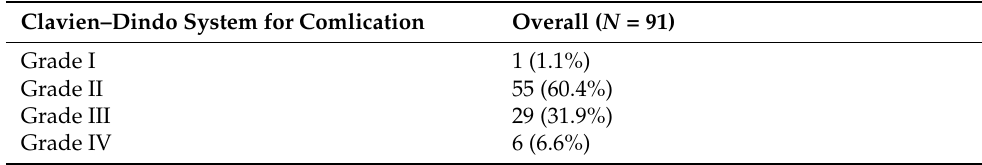
Table 4. Clavien–Dindo system analysis of ampullary